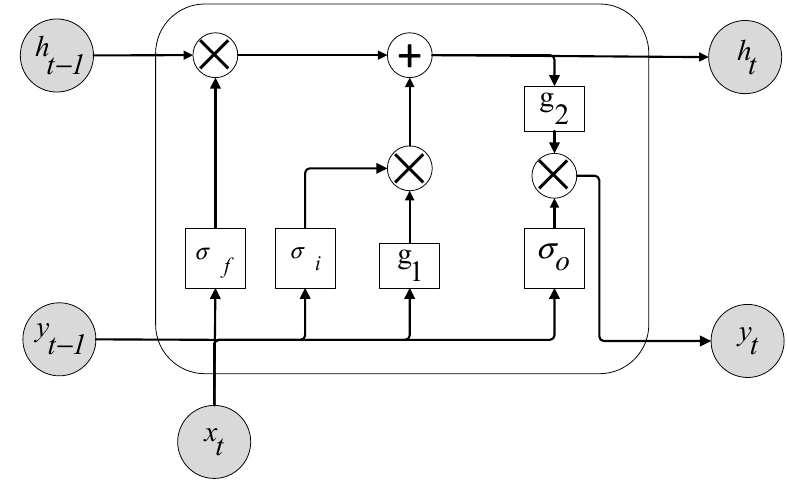
Figure A4. LSTM architecture. x , y and h represent input, output and hidden state, respectively. t is Figure A4. LSTM architecture. 𝑥, 𝑦 and ℎ represent input, output and hidden state, respectively. 𝑡 Figure A4. LSTM architecture. 𝑥, 𝑦 and ℎ represent input, output and hidden state, respectively. 𝑡 the time step. g 1 and g 2 are pointwise nonlinear activation functions. σ f , σ i and σ o represent forget, Figure A4. LSTM architecture. 𝑥, 𝑦 and ℎ represent input, output and hidden state, respectively. 𝑡 is the time step. 𝑔 (cid:2869) and 𝑔 (cid:2870) are pointwise nonlinear activation functions. 𝜎 (cid:3033) , 𝜎 (cid:3036) and 𝜎 (cid:3042) represent is the time step. 𝑔 (cid:2869) and 𝑔 (cid:2870) are pointwise nonlinear activation functions. 𝜎 (cid:3033) , 𝜎 (cid:3036) and 𝜎 (cid:3042) represent update and output gates, is the time step. 𝑔 (cid:2869) and 𝑔 (cid:2870) are pointwise nonlinear activation functions. 𝜎 (cid:3033) , 𝜎 (cid:3036) and 𝜎 (cid:3042) represent forget, update and output gates, respectively. forget, update and output gates, respectively. forget, update and output gates, respectively.